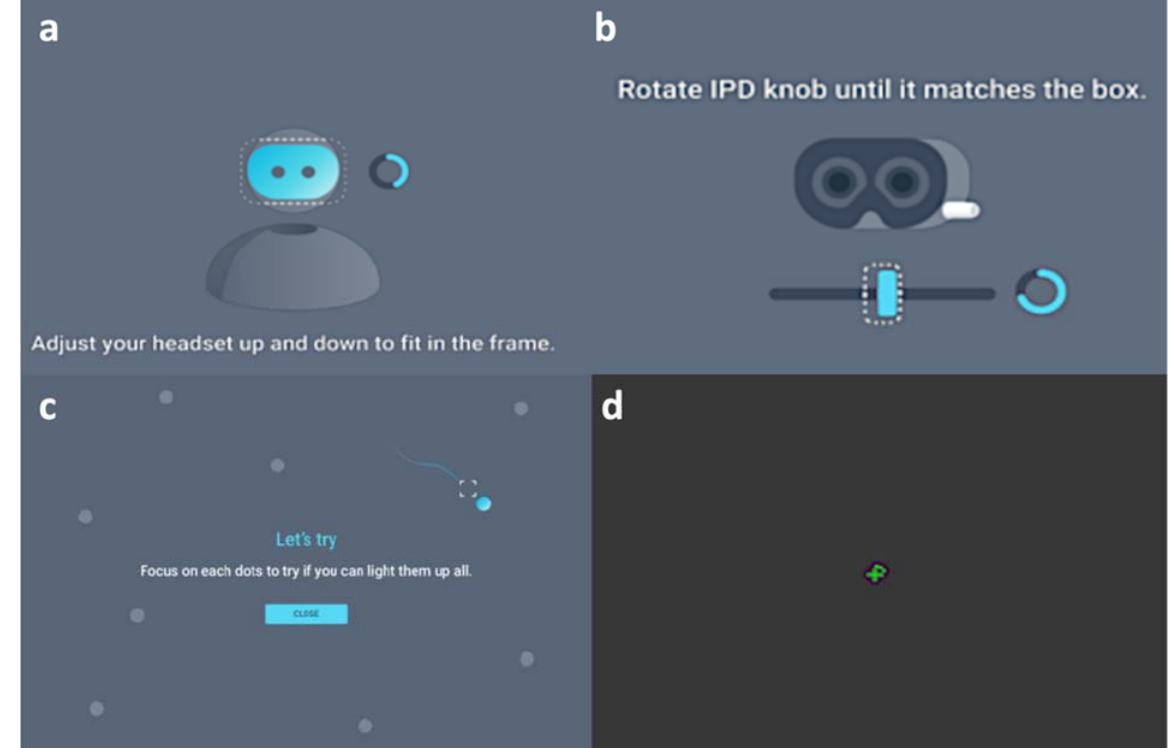
Figure 2. Demonstration of LUXIE/HTC Vive Pro Eye examination from the inside view. ( a ) Calibration of the headset position. ( b ) Calibration of the pupil distance. ( c ) Calibration of the eye-tracker ( d ), Demonstration of the central fixation green cross with a surrounding arc that will eventually become a circle along with the process of the test.